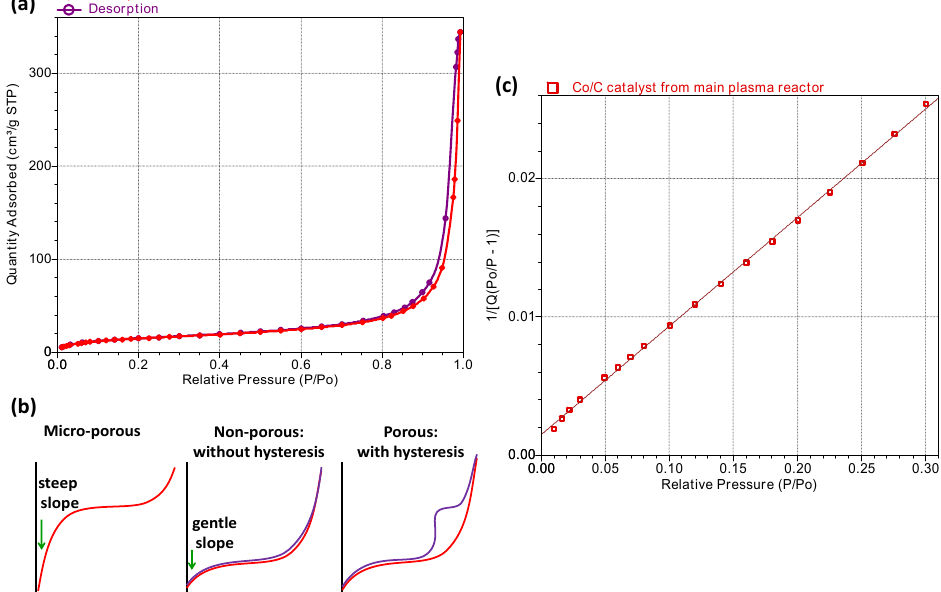
Figure 1. Porosity analysis of the fresh Co/C catalyst showing ( a ) overlaid adsorption-desorption isotherms; ( b ) cartoons with various impressions of isotherm interpretations; and ( c ) the BET transform plot.